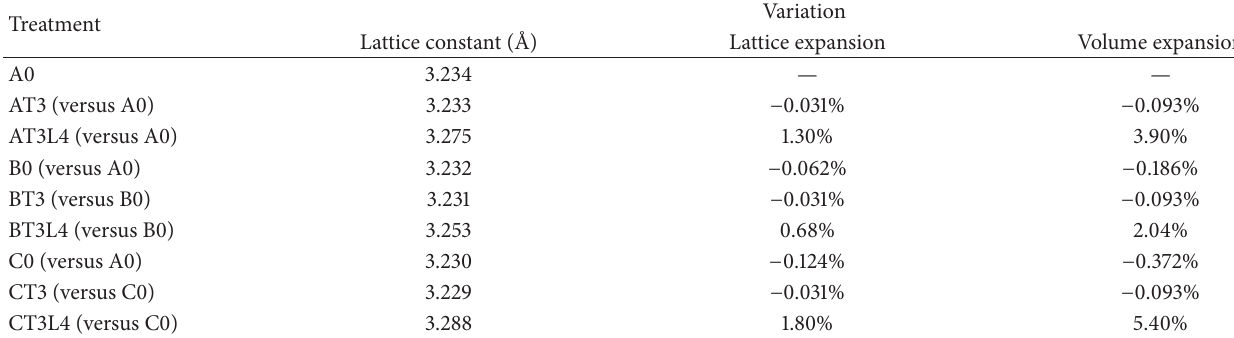
Table 5: Variations in lattice constant and volume expansion rate between typical treatments.